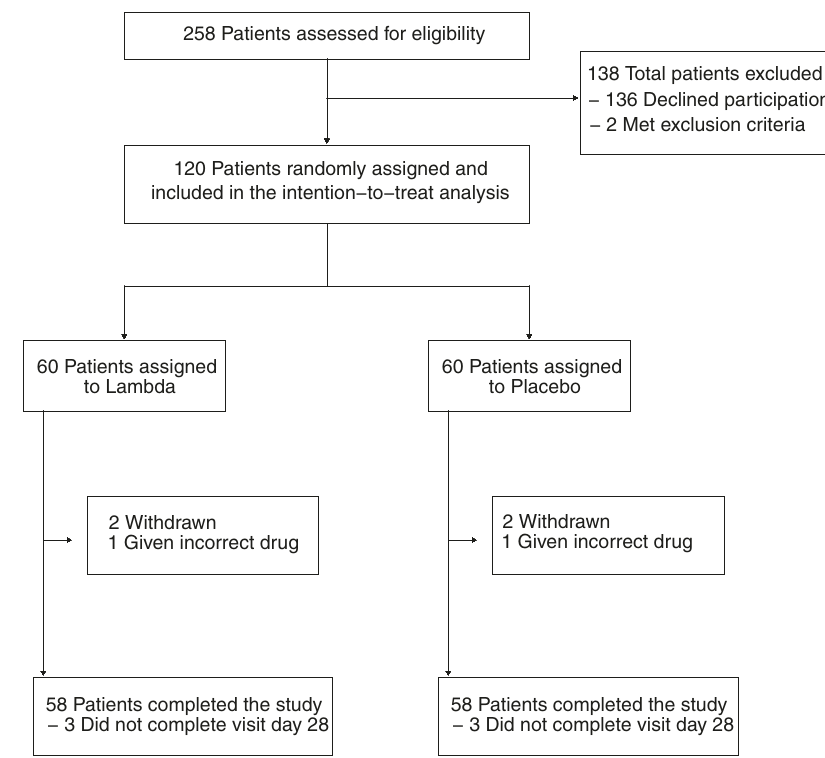
Fig. 1 CONSORT diagram. Trial schematic showing participants screened, randomized, and followed through study